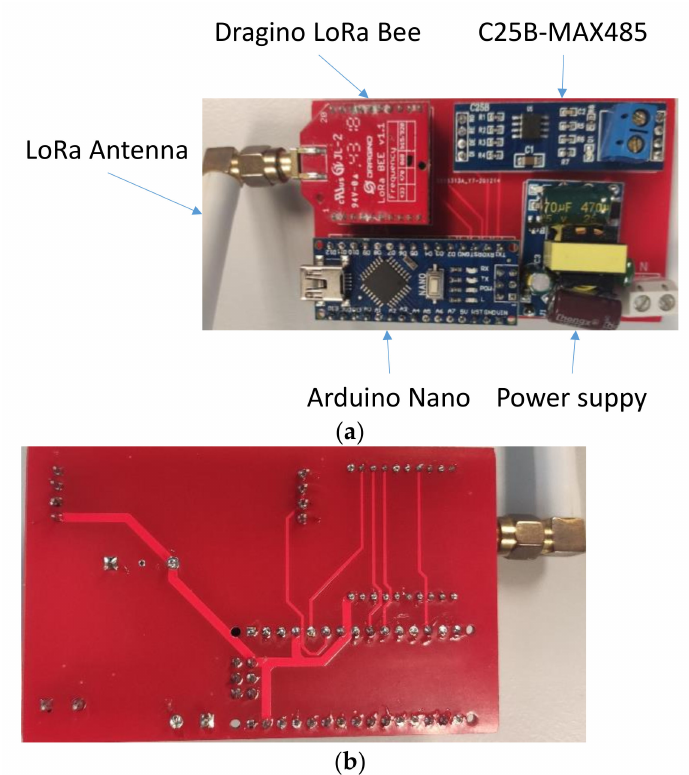
Figure 5. PCB board: ( a ) front side; ( b ) back side.